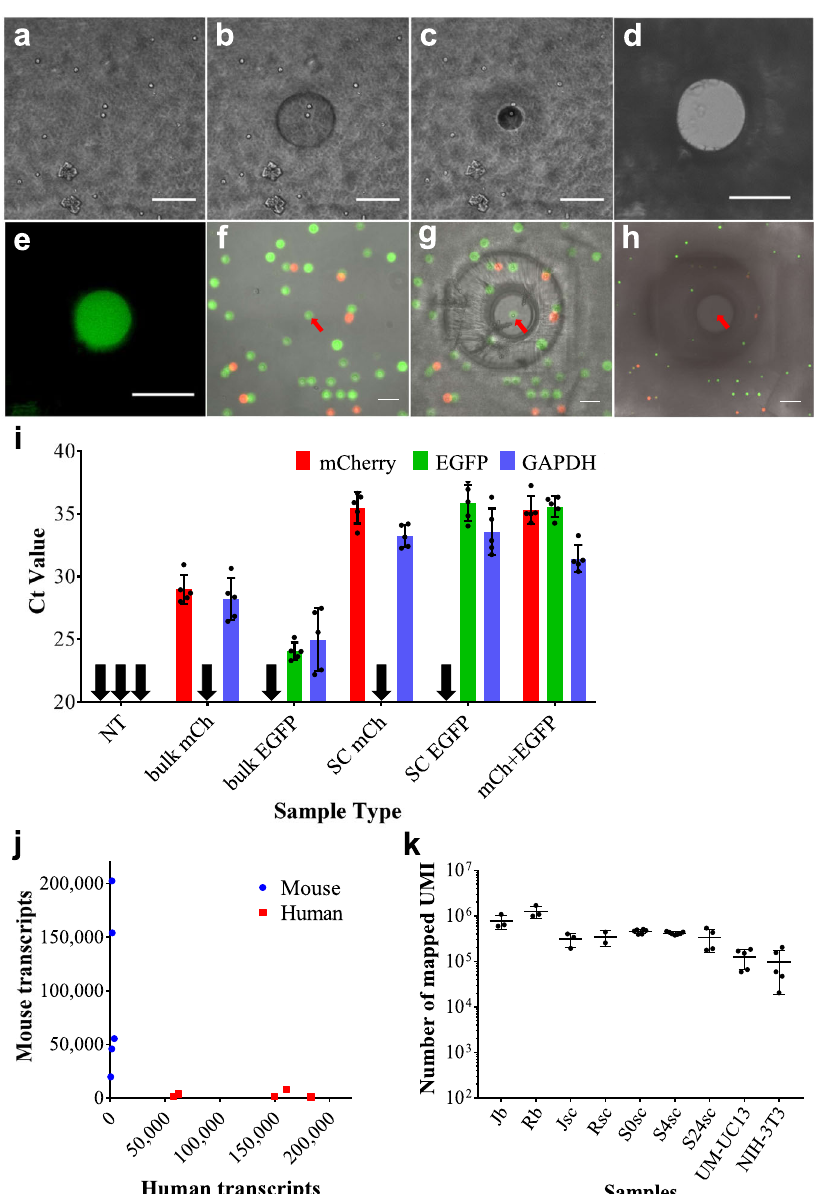
Fig. 2 Micropatterning hydrogel porosity to enable selective nucleic acid extraction. a Cells encapsulated in a porous hydrogel. b Micropatterning a 50 µ m void in the non-porous hydrogel using a 10× objective. c Further micropatterning a 12 µ m void using a 20× objective. d Bright- fi eld micrographs of a 50 µ m disk of porous hydrogel surrounded by non-porous hydrogel. e Diffusion of FITC-Dextran (Mw 10 kDa) into the porous hydrogel disk. g , h Selective single cell lysis using UM-UC13-mCherry (mCh) and UM-UC13-EGFP (EGFP) cells shown using overlaid bright- fi eld and fl uorescence micrographs. f mCh and EGFP cells encapsulated in porous hydrogel. g All non-target cells are embedded in non-porous hydrogel, while exposing a single target EGFP cell. h After addition of cell lysis buffer, only the target EGFP cell was lysed. Fluorescence of non-target cells is reduced due to dehydration, but not eliminated. i qPCR for RNA selectively extracted from mixed mCh and EGFP cell samples including no-template control (NT), bulk mCh, bulk EGFP, single cell mCh, single cell EGFP, as well as one mCh and one EGFP cell. Black arrows indicate target cDNA undetectable. Ct values are averaged from N = 5. j See-N-Seq analysis from mixtures of mouse and human cells. The scatter plot shows the number of unique human and mouse transcripts associating to each sample. Blue dots indicating mouse single cells while red dots indicating human single cells. N = 5. k Mapped UMI counts per each sample group. All scale bars = 50 µ